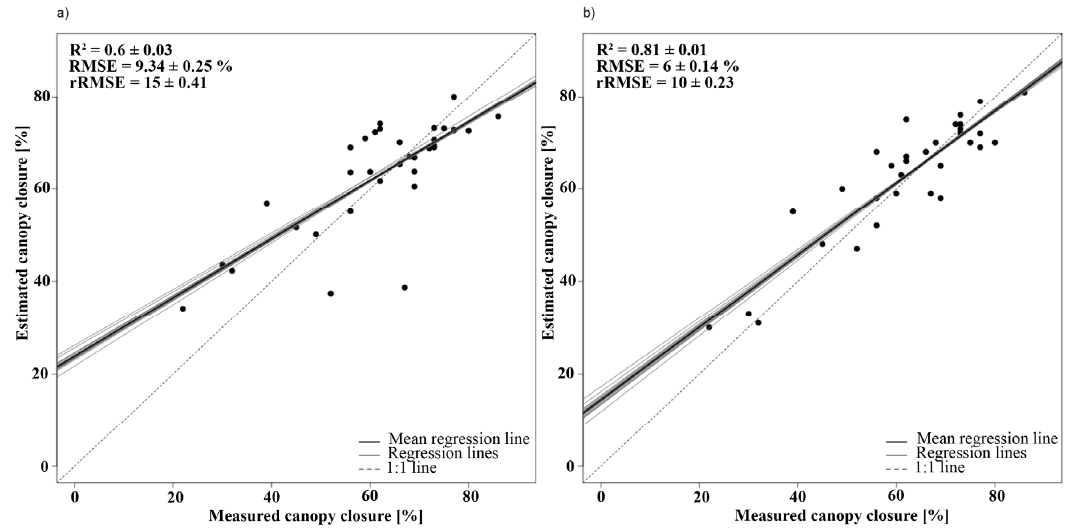
Figure 3. Agreement of estimated canopy closure with in-situ data; ( a ) simple regression model based on a PVI (perpendicular vegetation index) index; ( b ) stepwise multiple regression model based on band depth indices and an SR (simple ratio) type index. The corresponding wavelengths of the indices are given in Table 3. Coefficient of determination (R 2 ± SD), root mean square error (RMSE ± SD), and relative root mean square error of prediction (rRMSE ± SD) are shown.